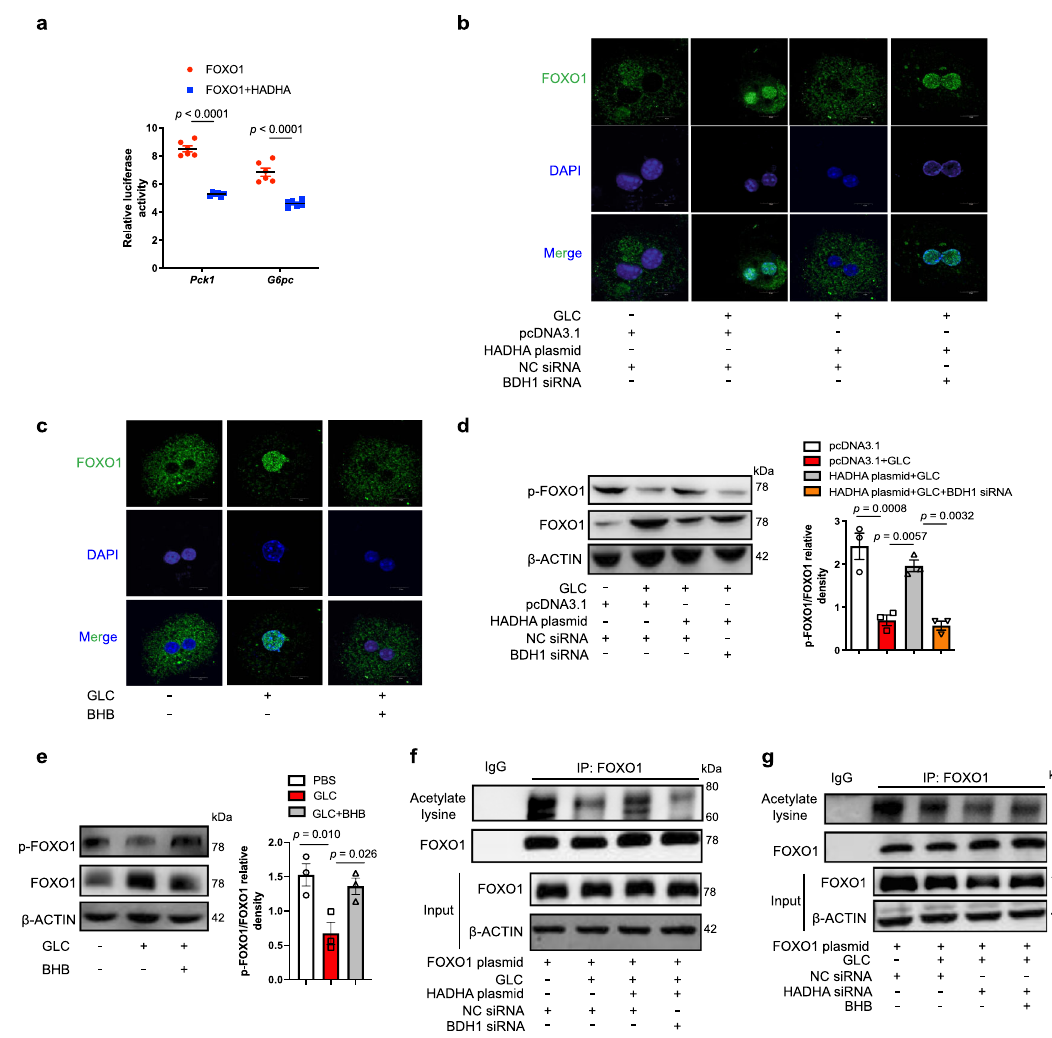
Fig. 4 HADHA and BHB inhibited glucagon-induced FOXO1 activation. a Luciferase reporter assay of the inhibitory effect of HADHA on Pck1 and G6pc gene promoter co-transfected with HADHA and FOXO1 plasmid in HEK-293T cells. The luciferase activity was normalized with the internal control (Renilla luciferase, n = 6). b Representative confocal images of FOXO1 nuclear translocation in HADHA-overexpressed primary hepatocytes with or without BDH1 siRNA transfection and 100 nM glucagon stimulation for 1 h. Scale bar represents 10 μ m. c Confocal images of FOXO1 nuclear translocation in BHB (400 μ M, 6 h) treated primary hepatocytes when exposed to glucagon (100 nM, 1 h). Scale bar represents 10 μ m. d FOXO1 phosphorylation from the hepatocytes in b ( n = 3). e FOXO1 phosphorylation from the hepatocytes in panel c ( n = 3). f, g FOXO1 acetylation in HADHA-overexpressed or knockdown primary hepatocytes transfected with BDH1 siRNA and 100 nM glucagon stimulation for 1 h. b , c , f and g were repeated 3 times independently with similar results. BHB β -hydroxybutyrate, GLC glucagon, NC normal control. Values represent mean ± SEM. Statistical differences were determined by one-way ANOVA. Source data are provided as a Source Data fi